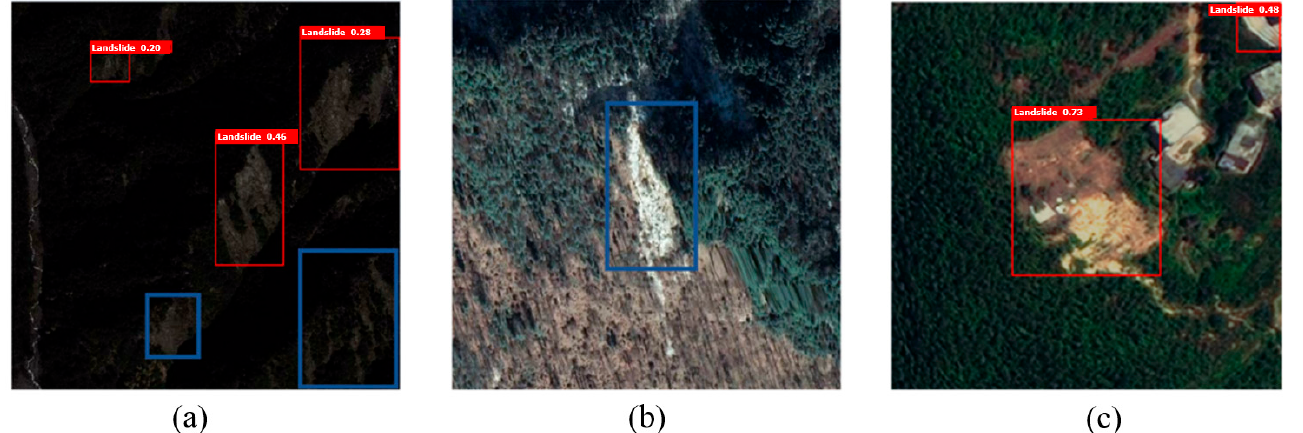
Figure 17. Illustration of the results with partial error detection. ( a ) Landslide Detection in Dark Environment, ( b ) Detection of landslides similar to the surrounding environment and ( c ) Detection of Landslides in Residential